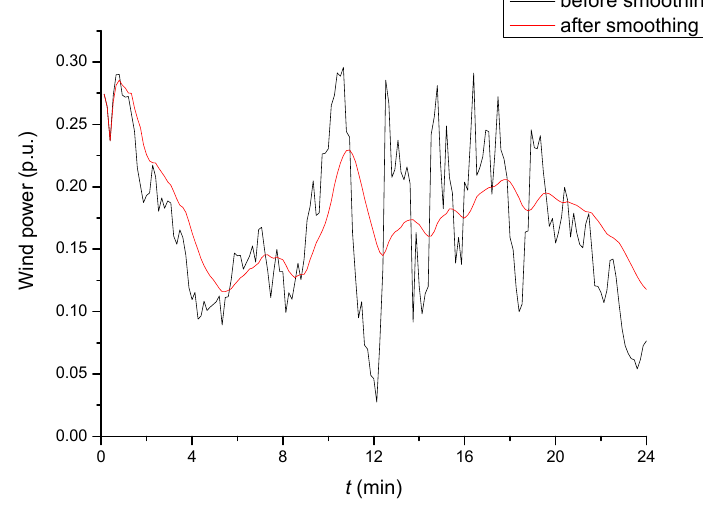
Figure 4. Wind power before and after smoothing.